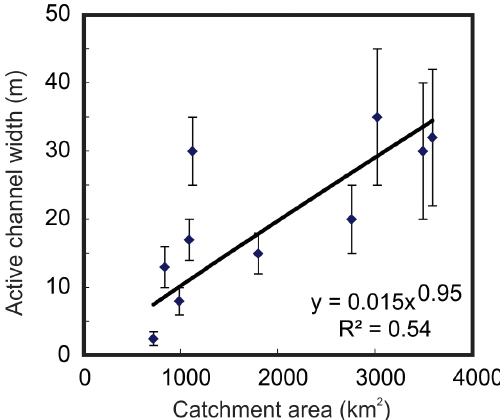
Figure 7. Active-channel-width-to-area scaling for the Pisco